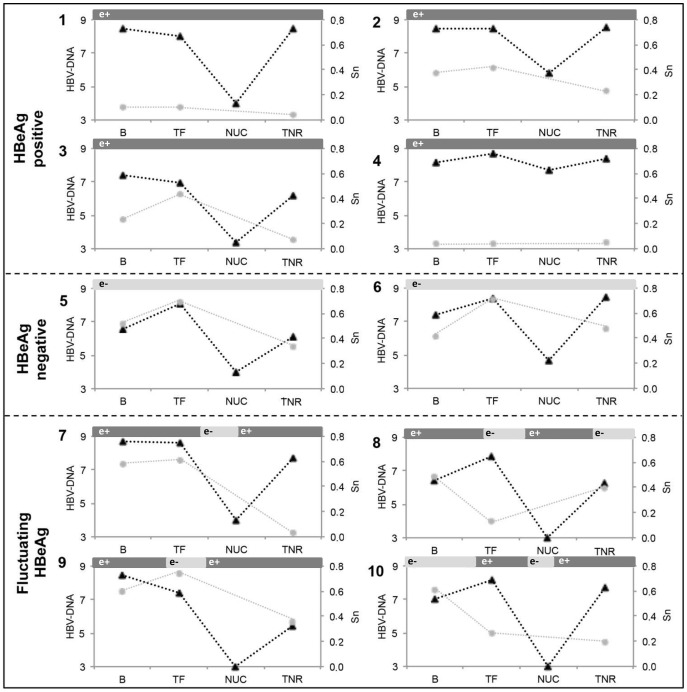
Viral replication and QA evolution of the 10 patients included in the study.The left axis and black-dotted lines represent HBV-DNA (log IU/mL), and the right axis and grey lines represent Sn in baseline (B), treatment-free (TF), and treatment-nonresponse (TNR) samples. HBV DNA level during LVD treatment is indicated as NUC. HBeAg status is shown in bars over the graph: dark grey bar, HBeAg-positive and light grey bar, HBeAg-negative.